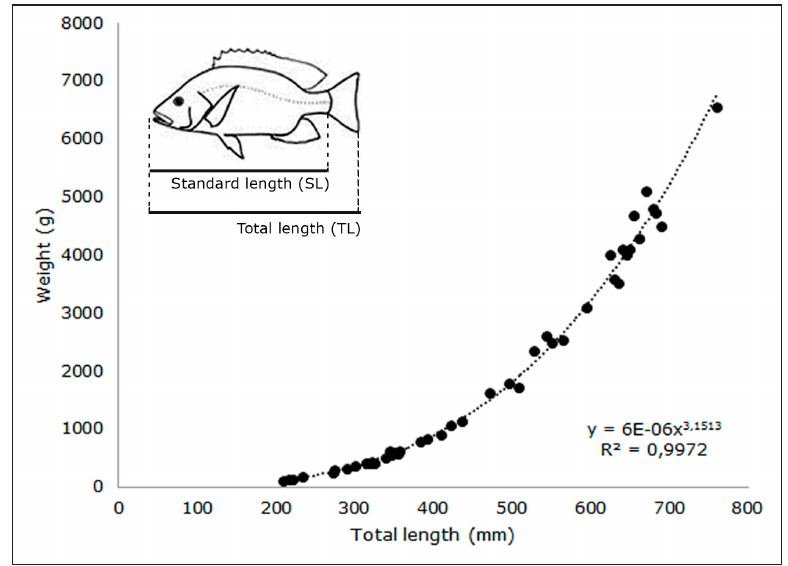
FIGURE 3 | Total length (TL) to weight relationship of the modern sample of Lutjanus argentiventris.